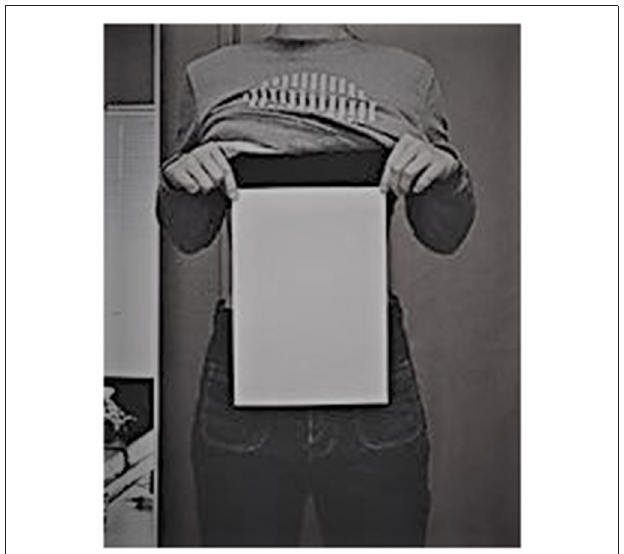
FIGURE 1 | Illustration of woman taking and passing the A4